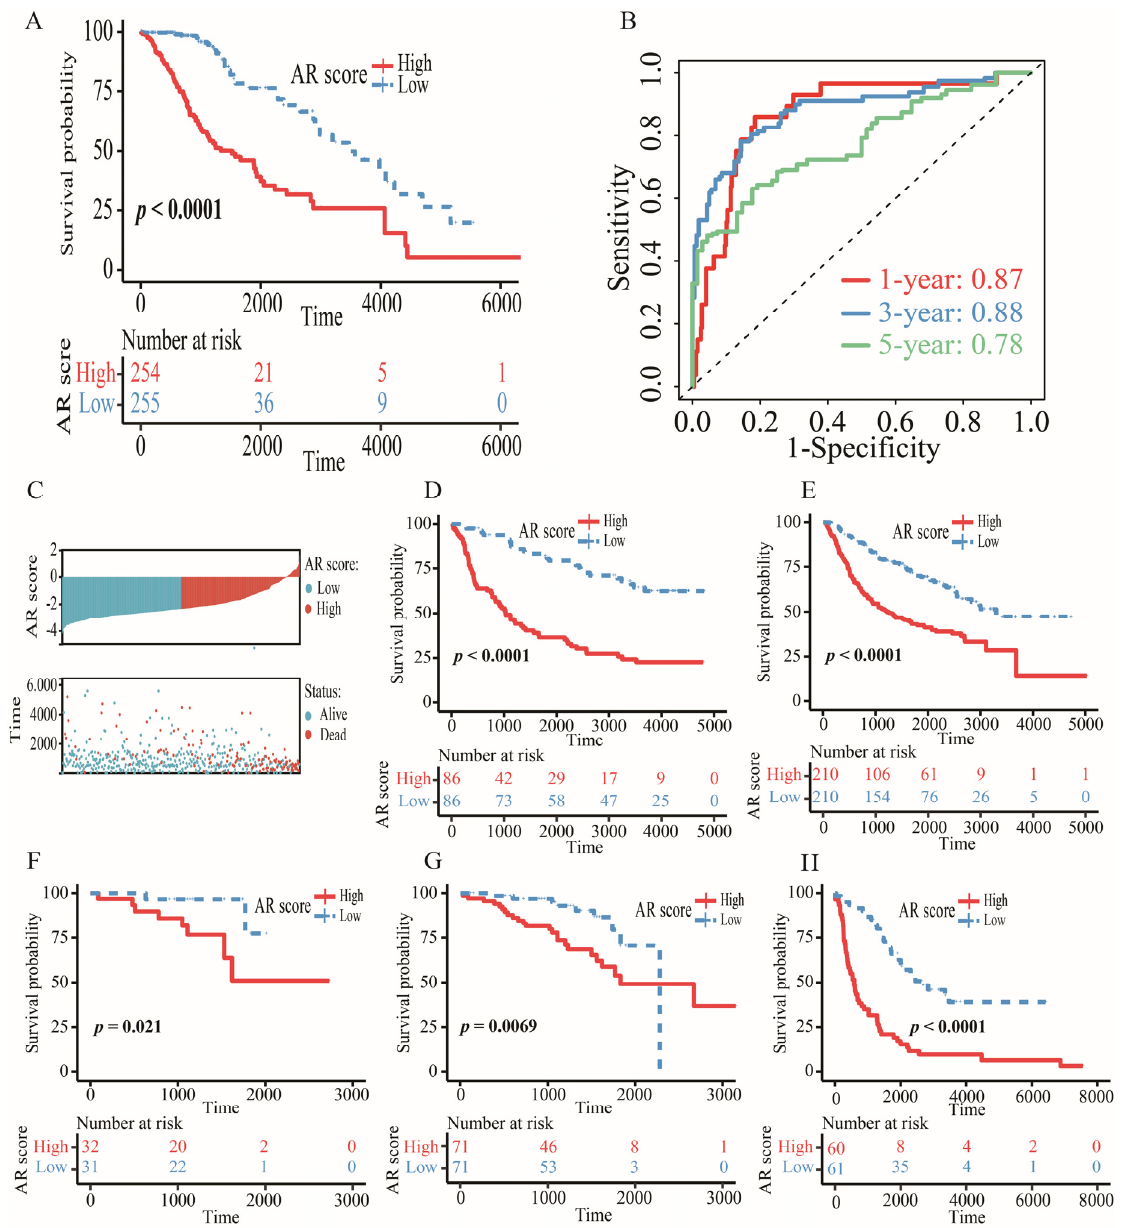
Figure 3. The prognostic value of AR-related gene signature. ( A ) Kaplan–Meier survival analysis of OS between high- and low-AR groups in TCGA. ( B ) The AUC of 1-, 3-, and 5-year OS in TCGA. ( C ) The distribution of AR score and survival status in TCGA. ( D – H ) Kaplan–Meier survival analysis of OS between high- and low-AR groups in CGGA-325, CGGA-693, E-MTAB-2768, E-MTAB-3892 and Rembrandt, respectively.